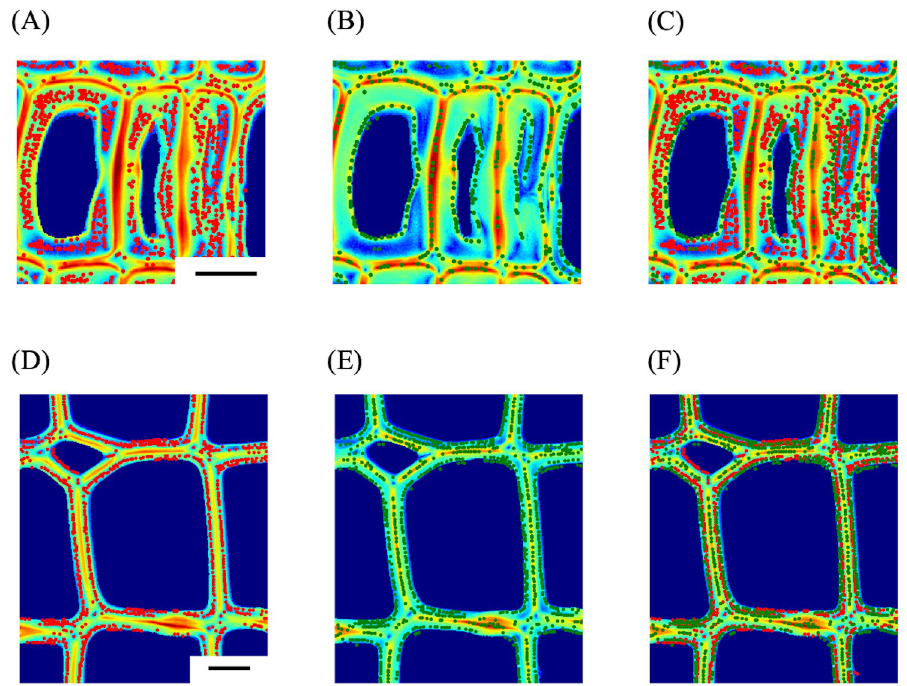
Fig 5. Selective detection of S 2 or S 1 +S 3 layers. (A) S 2 detection and (B) S 1 +S 3 detection in a latewood, (D) S 2 detection and (E) S 1 +S3 detection in an earlywood. (C) and (F) are merged images of (A) and (B), and (D) and (E), respectively. Red and green dots correspond to the detected S 2 (local-intensity minima) and S 1 +S 3 (local-intensity maxima) layers’ contributions, respectively. Bars, 10 μ